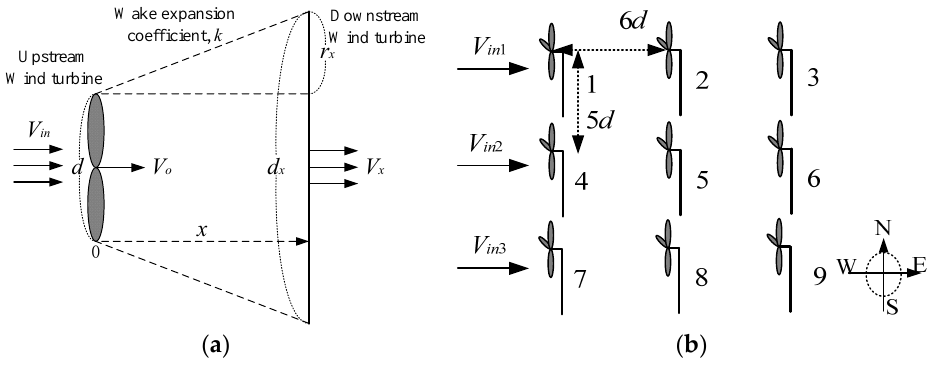
Figure 3. The wake effect model. ( a ) Jensen model principle; ( b ) wind turbine distribution structure.